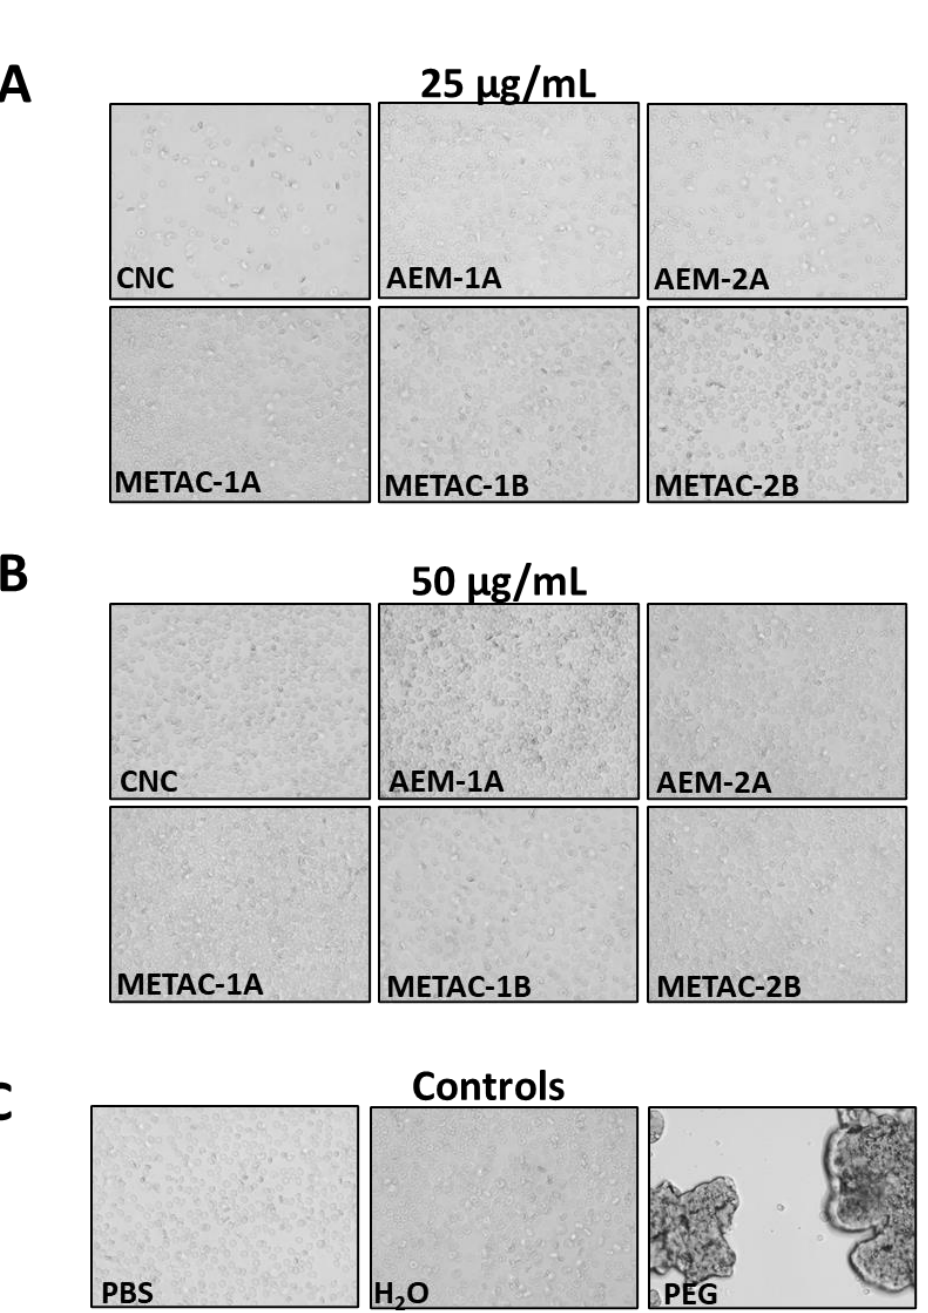
Figure 2. Effect of unmodified and modified CNCs on RBC morphology and aggregation. Diluted human blood was treated for 2 h with ( A ) 25 µg/mL or ( B ) 50 µg/mL of unmodified and modified CNCs, or with controls, ( C ) PBS, ultrapure H 2 O, and PEG 1 mg/mL. The pictures were captured using a bright-field inverted microscope (400×).